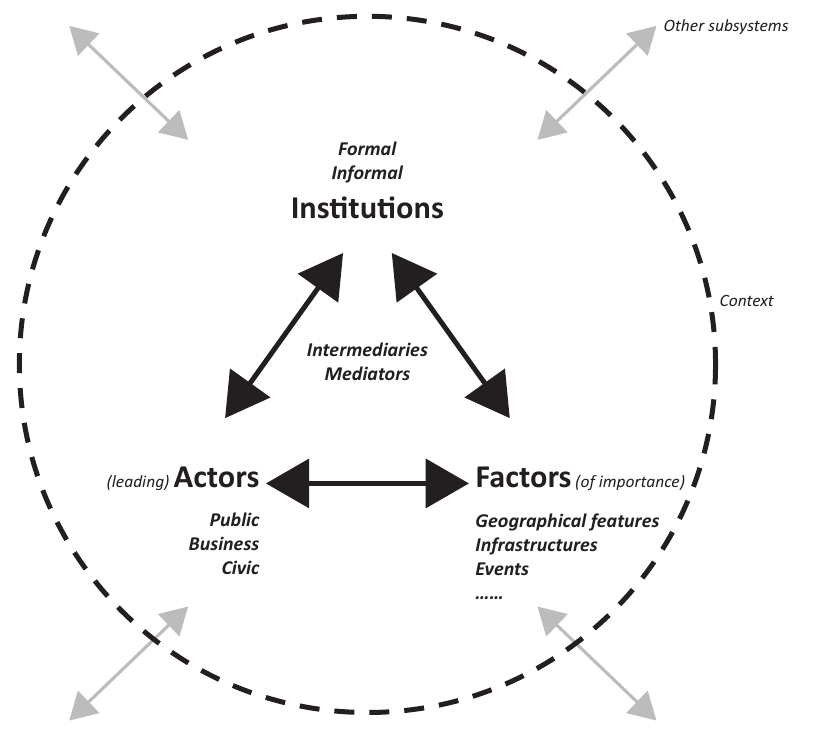
Figure 1. Scheme of an actor‐relational subsystem. Source: Boelens (2018, p. 96). influence each other back and forth and result in a new evolution being